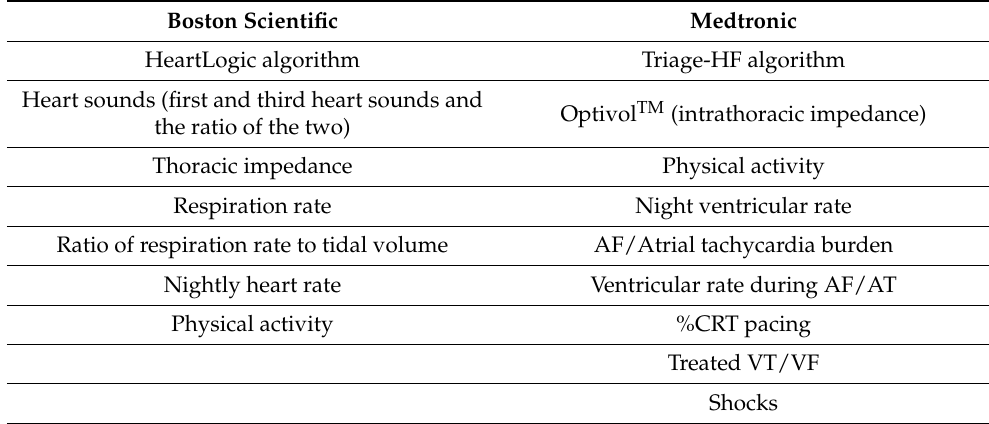
Table 1. Overview of available multisensor